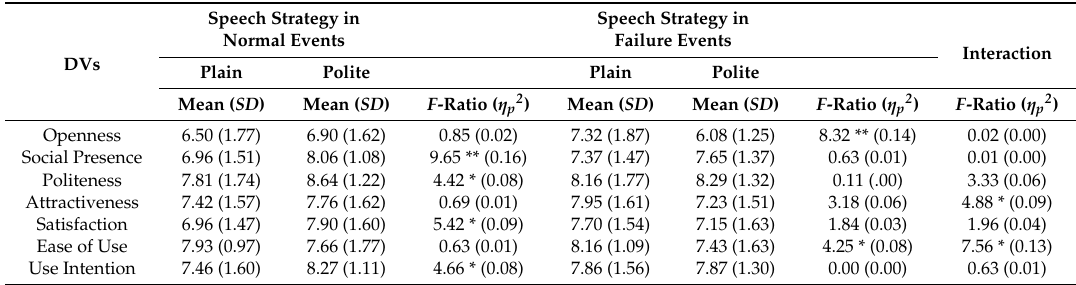
Table 1. Results of MANOVA Testing.